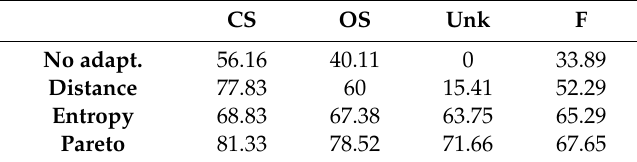
Table 6. Classification results obtained for the scenario Vaihingen → Trento.